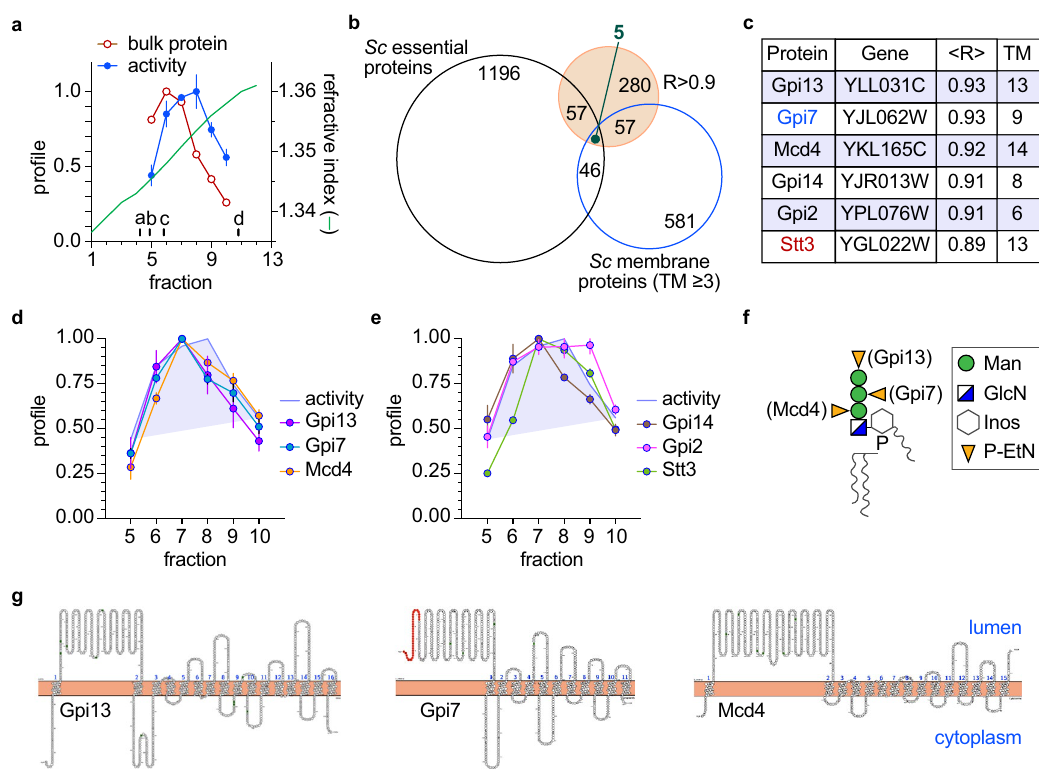
Figure 3. Identification of M5-DLO scramblase candidates by activity correlation profiling. ( a ) Yeast TE was fractionated by velocity sedimentation on a 5–25% glycerol gradient and fractions were collected from the top. Sedimentation standards (indicated as a-d: 2.8, 3.6, 4.2 and 8.9S) were resolved in parallel. The profiles of bulk protein (open circles) and M5-DLO scramblase activity (solid circles, duplicate measurements) are indicated, along with the refractive index (green line) of the fractions. ( b ) Venn diagram describing the selection of M5-DLO scramblase candidates. Mass spectrometry identified 280 proteins with a correlation coefficient R > 0.9 (filled circle). Intersections between this group and the groups of all essential proteins in yeast ( Sc essential proteins), and yeast membrane proteins with three or more predicted transmembrane spans ( Sc membrane proteins (TM ≥ 3, assessed by the TMHMM membrane protein topology prediction program)) yielded 5 proteins. One of these (Neo1) was discarded because it is not an ER resident. ( c ) List of M5-DLO scramblase candidates. The four ER membrane proteins obtained at the intersection of the Venn diagram are listed. Gpi7 and Stt3 were included for reasons discussed in the text. ( d ) Profiles of Gpi13, Gpi7 and Mcd4 vs the activity profile (shaded and outlined in blue). See also Fig. S4. ( e ) Profiles of Gpi14, Gpi2 and Stt3 vs the activity profile (shaded and outlined in blue). ( f ) Role of Gpi13, Gpi7 and Mcd4 in GPI P-EtN transfer reactions. The structure of the mature GPI anchor precursor in yeast and mammals is shown. Mcd4, Gpi7 and Gpi13 add the first, second and third P-EtN residues, respectively. T. brucei possesses Gpi13 but lacks homologs of Mcd4 and Gpi7. ( g ) Membrane topology of Gpi13, Gpi7 and Mcd4 assessed using Protter 67 and placed in the context of the ER membrane (horizontal bar). A predicted signal sequence at the N-terminus of Gpi7 is indicated in red. The number of predicted transmembrane spans differs slightly from the number predicted by the TMHMM server that was used to calculate the Venn diagram group ’ Sc membrane proteins (TM ≥